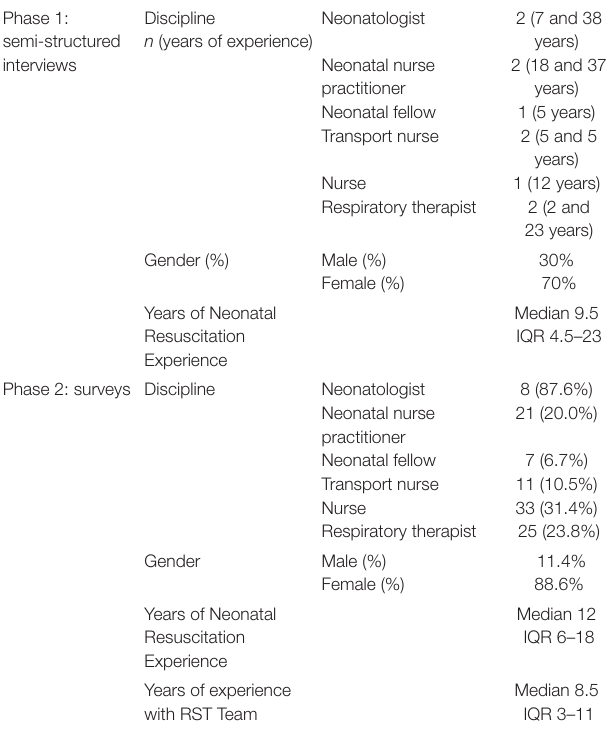
TABLE 1 | Participant demographics. Phase 1: